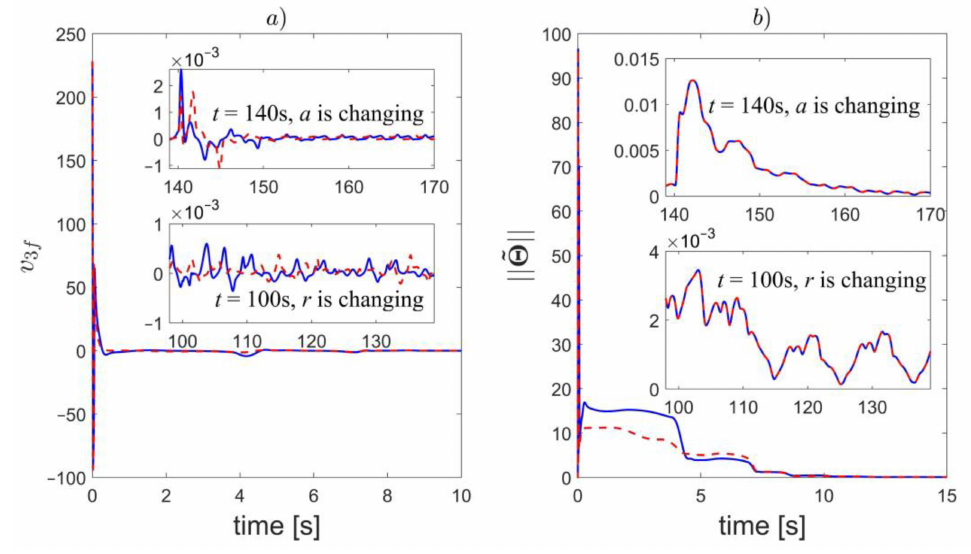
Figure 9. ( a ) Tracking error v 3 f ; ( b ) norm of parameter estimation errors (cid:107) (cid:101) Θ (cid:107) ; design parameters: K 1 = K 2 = K 3 = 10, solid line; design parameters: K 1 = K 2 = K 3 = 15, dashed line.